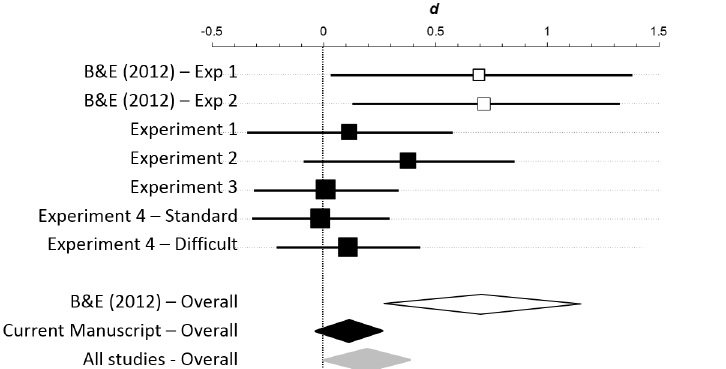
Fig 1. Meta-analysis of the effects of power on performance. At top are shown results the two experiments in Burgmer & Englich [2] (B&E (2012) – white squares) and from Experiments 1 – 4 from this paper (black squares). For each experiment, the unbiased effect size is represented by a square scaled to reflect proportionate sample size. The 95% confidence interval for the effect size is represented by a horizontal line. At bottom is shown the overall weighted effect sizes across Burgmer & Englich ’ s two studies (white diamond), Experiments 1 – 4 from this paper (black diamond), and across all studies (grey diamond). The center of the diamond represents the estimated effect size, the horizontal span of the diamond represents the 95% confidence interval for that effect. This figure was generated with the Meta-Analysis module in the Exploratory Software for Confidence Intervals package for Microsoft Excel (Cumming,